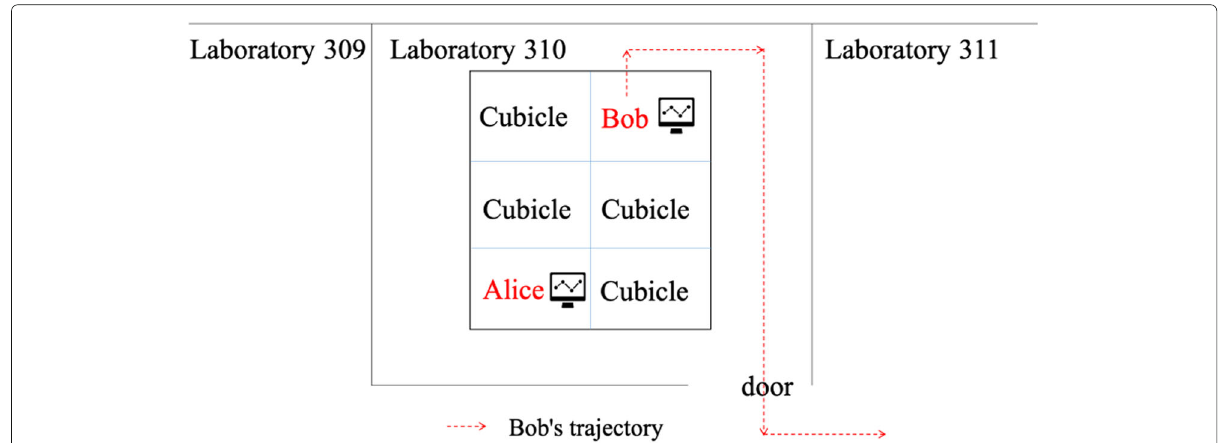
Fig. 11 Experimental